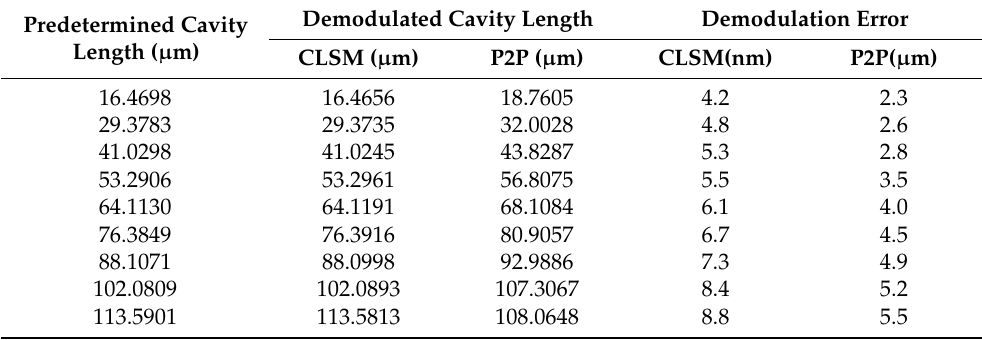
Table 2. Experimental demodulation results of 15–115- µ m fiber-optic FP sensors by the CLSM algorithm. Predetermined